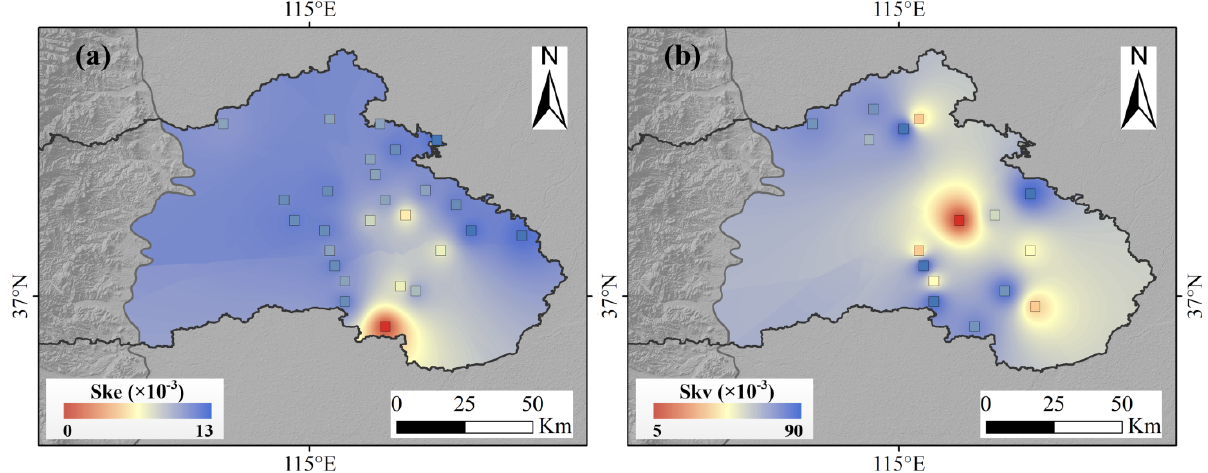
Figure 12. The spatial distribution of estimated ( a ) elastic and ( b ) inelastic skeletal storativity, using hydraulic head observations and InSAR derived displacement time series during 2016~2017. The squares mark the observation wells used to estimate skeletal storativity.